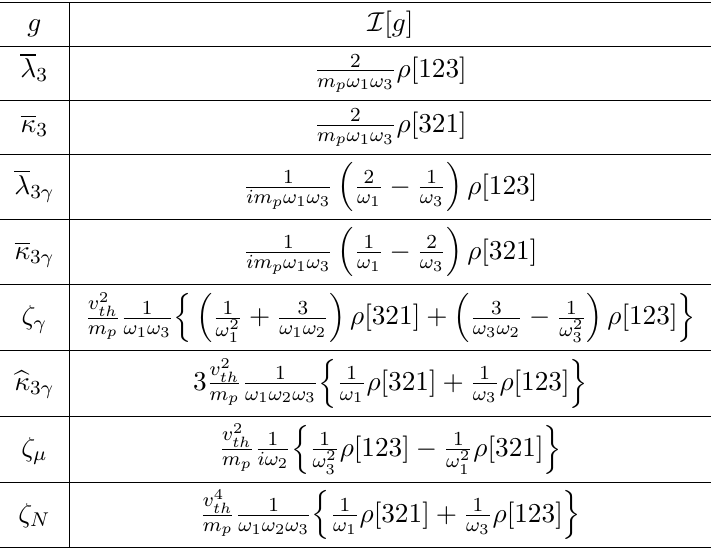
Table 6 . Sum rules for Coupling (High Temperature